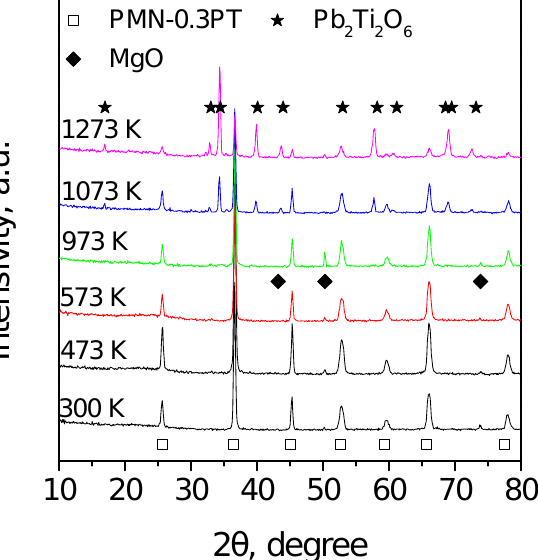
Figure 4. X-ray diffraction patterns of 8 t sample treated at different temperatures. The temperature dependencies of the dielectric permittivity at different frequencies of 3 t and 6 t samples are presented in Figure 5. The results of the 8 t sample are close to 6 t, so only one frequency of 100 kHz is presented for comparison. The real part of ε (cid:48) of the studied samples demonstrates a broad maximum near 460 K. The anomaly is related to the phase transition of 0.7Pb(Mg 1/3 Nb 2/3 )O 3 -0.3PbTiO 3 from ferroelectric to